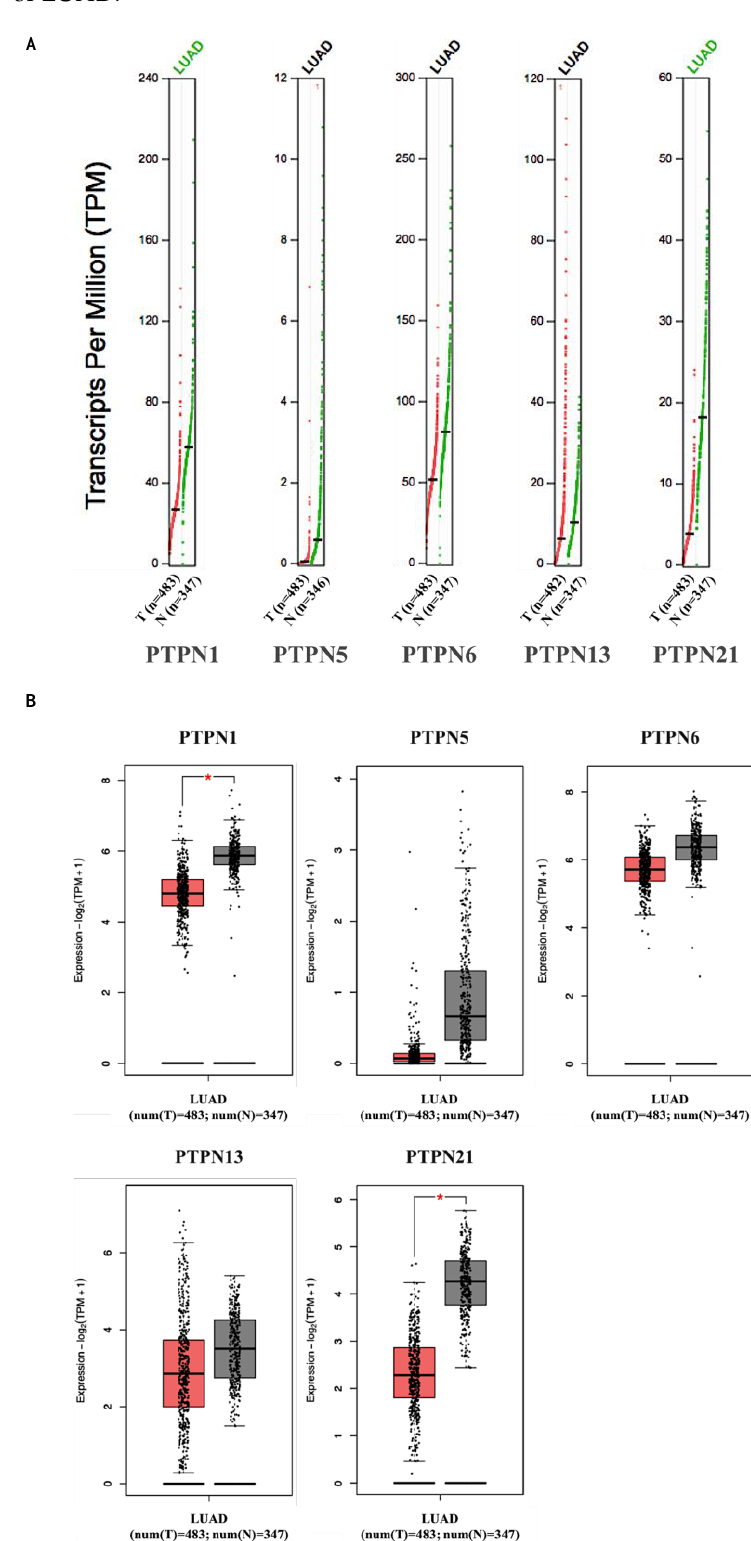
Figure 4. ( A , B ) Expressions of PTPN members in LUAD patients and normal tissue via the GEPIA 2 platform. The q-value cut-off was set to 0.01. The red star in the pictures indicates a significant difference between LUAD and normal